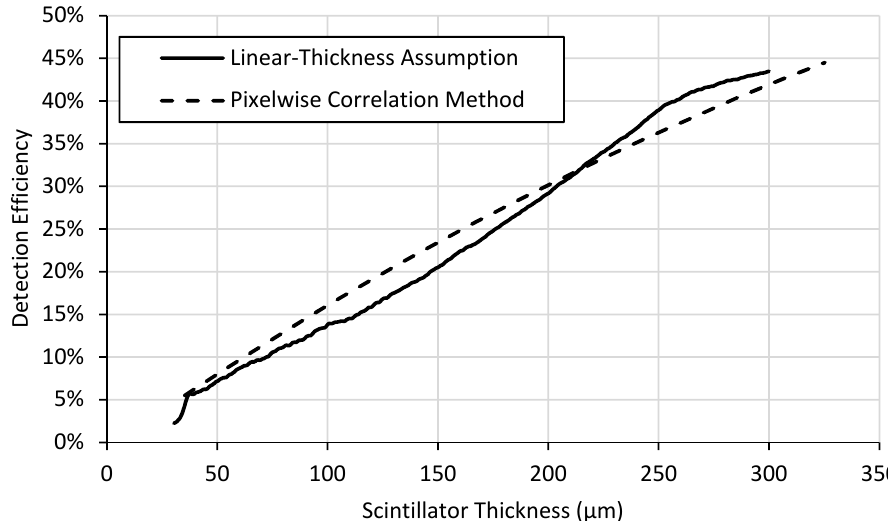
Figure 8. Neutron detection e ffi ciency calculated using the two di ff erent methods for a 6 LiF:ZnS test-screen.